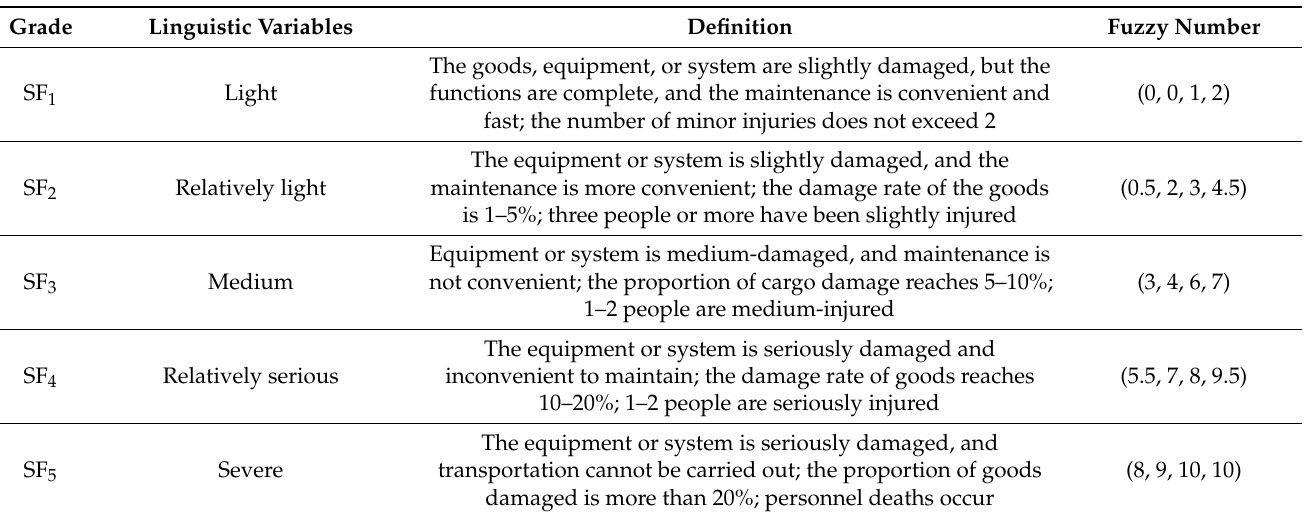
Table 7. Safety and security loss SF fuzzy assessment level.